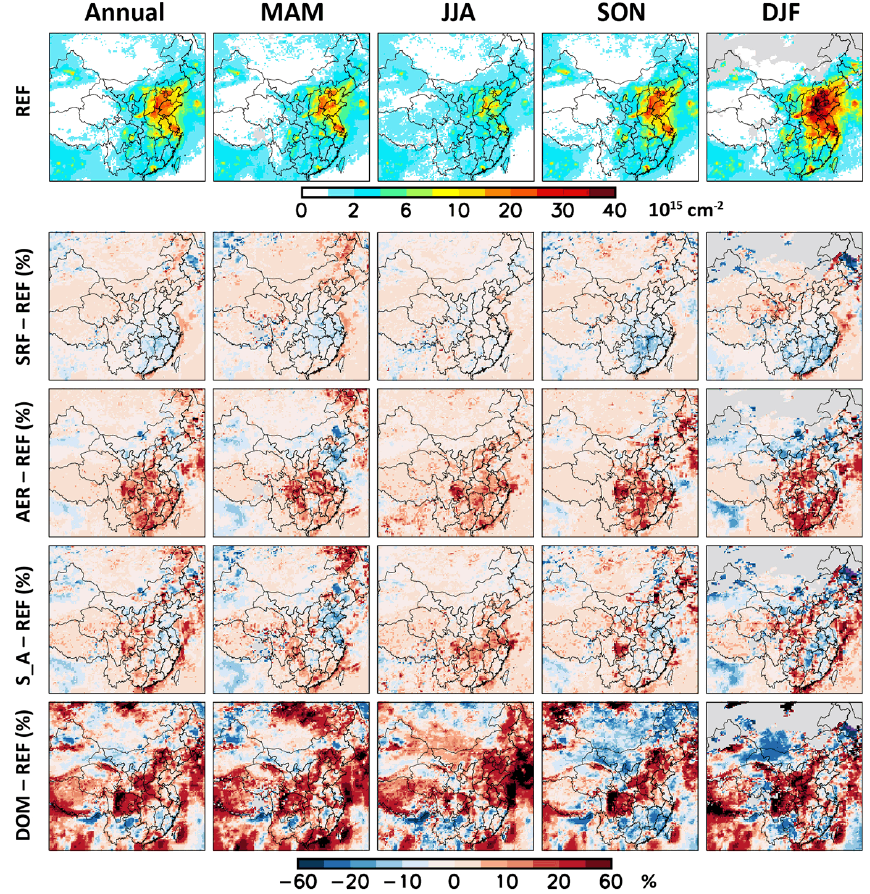
Figure 5. First row: tropospheric NO 2 VCDs retrieved from case REF at annual and seasonal scales. Second–fifth rows: changes in NO 2 VCDs from case REF to other cases as a percentage fraction of case REF. Provincial boundaries of China are shown. Data are sampled from valid pixels of case REF. Values outside the upper (lower) bound of color intervals are shown in black (purple). Missing values are shown in grey. Color intervals are nonlinear to better present the data range; an interval without labeling represents the mean of the adjacent two